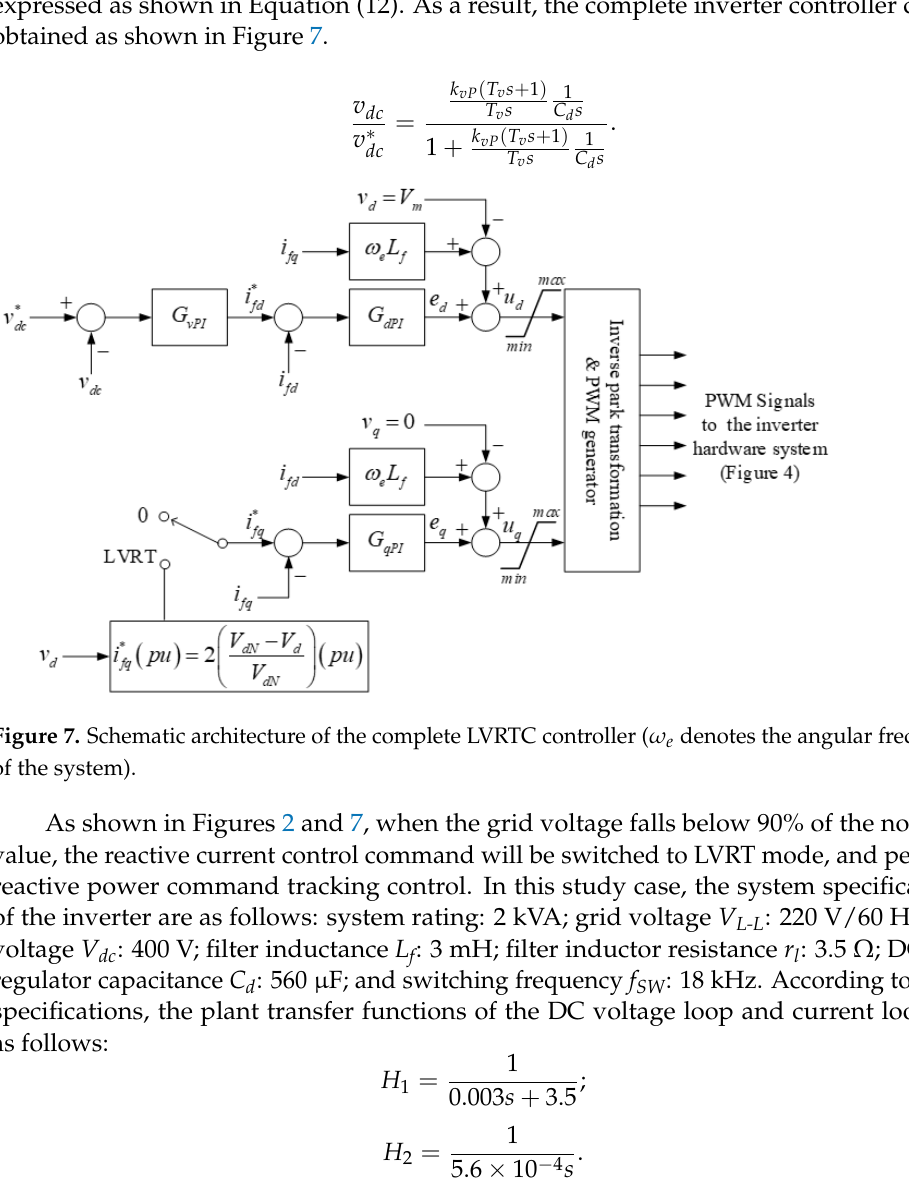
Figure 6. Schematic architecture of the DC voltage controller. Based on Figure 6, the close-loop transfer function of the DC voltage controller can be expressed as shown in Equation (12). As a result, the complete inverter controller can be obtained as shown in Figure 7.